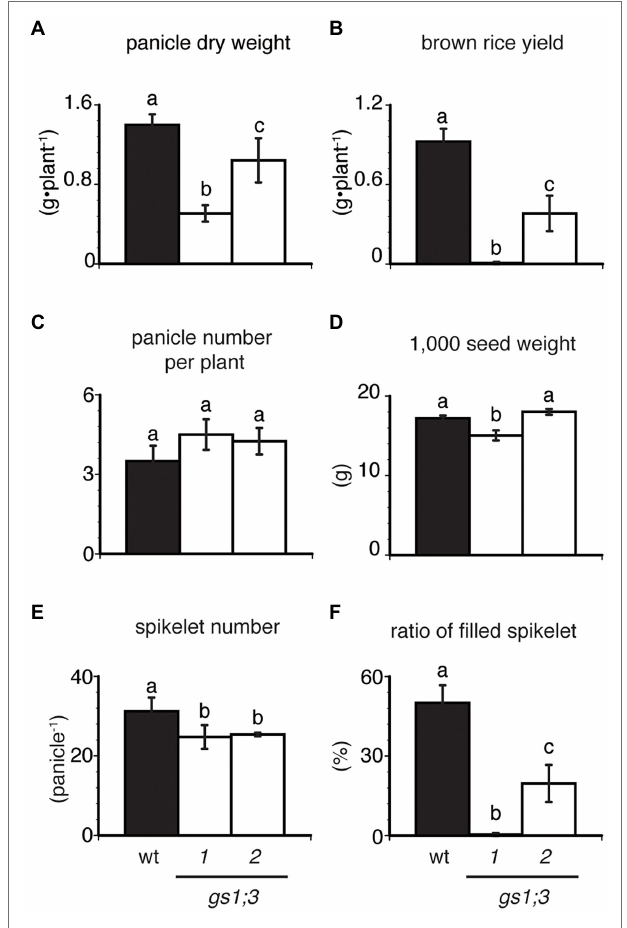
FIGURE 6 | Productivity and growth of GS1;3 mutants in hydroponic culture. (A) panicle dry weight, (B) brown rice yield, (C) panicle number per plant, (D) 1,000 seed weight, (E) spikelet number per panicle, and (F) ratio of filled spikelets of WT and GS1;3 mutant plants grown in hydroponic culture with 0.5 mM NH 4+ are shown. All samples were harvested 61 days after heading. Data represent mean ± SD ( n = 5). Significant differences within each group were determined using one-way analysis of variance (ANOVA) followed by Bonferroni tests and are indicated with different letters ( p <